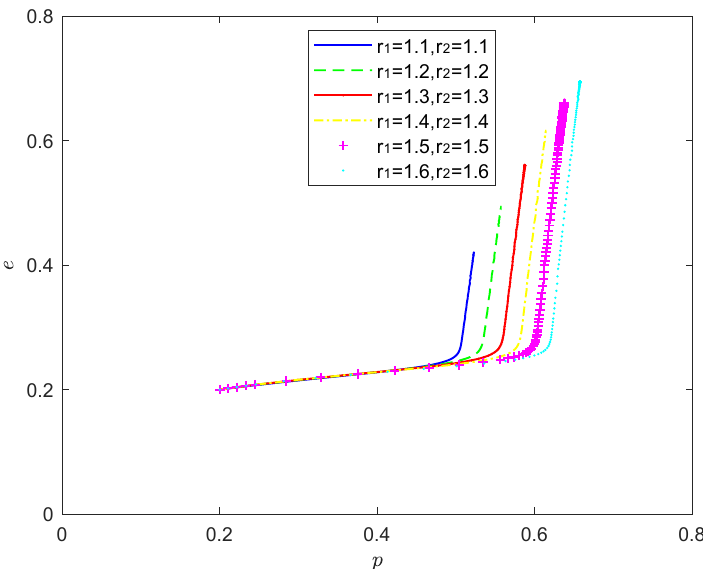
Figure 5. Evolution of game strategy in (pessimistic, pessimistic) state.